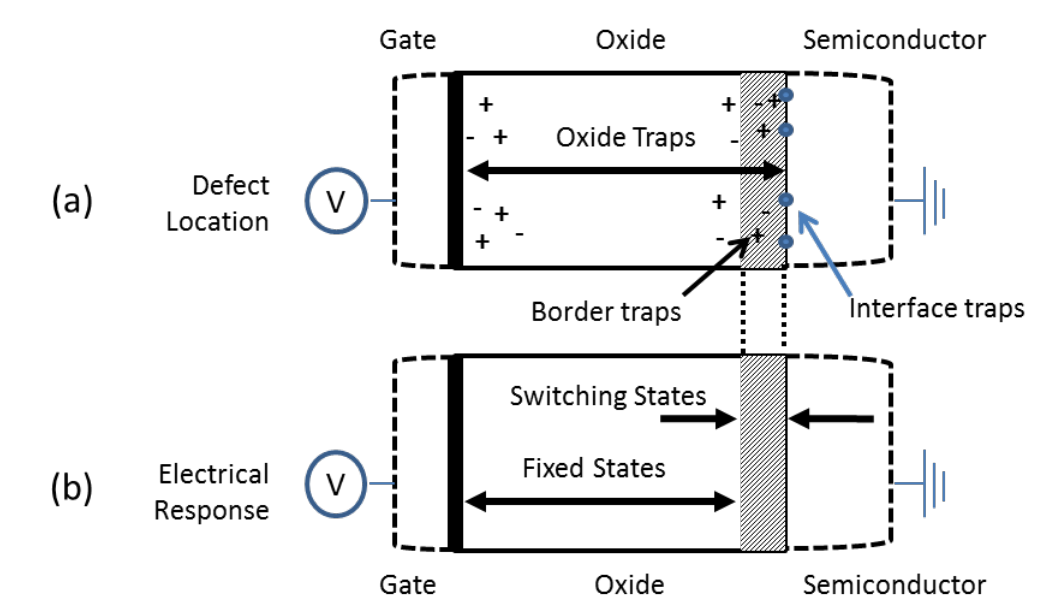
Figure 13. Schematic illustration of border